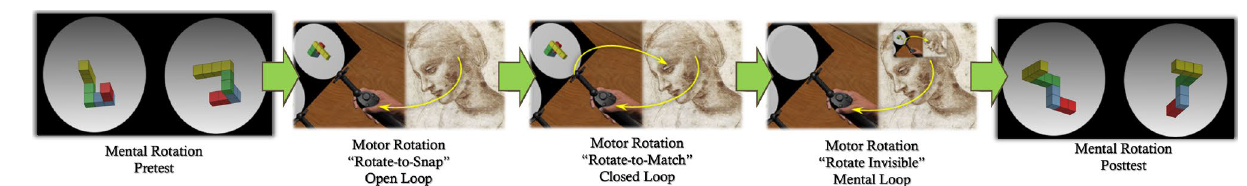
Figure 4. The experiment’s trial sequence, from left to right, beginning with mental-rotation pretest, followed by the three motor-control blocks, and ending with another mental-rotation